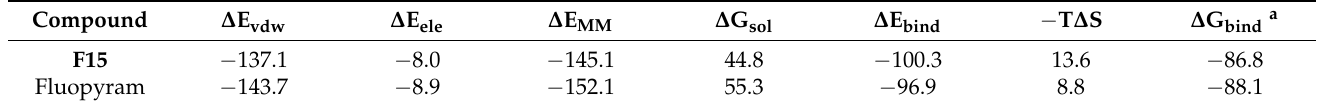
Figure 6. Virtual molecular docking comparisons of title compound F15 ( A ) and fluopyram ( B ) with SDH (PDB code: 2FBW). Hydrogen bond interactions are indicated by a green line, and the π – π interactions are indicated by a purple line. Table 6. The binding energies of compound F15 and fluopyram with SDH